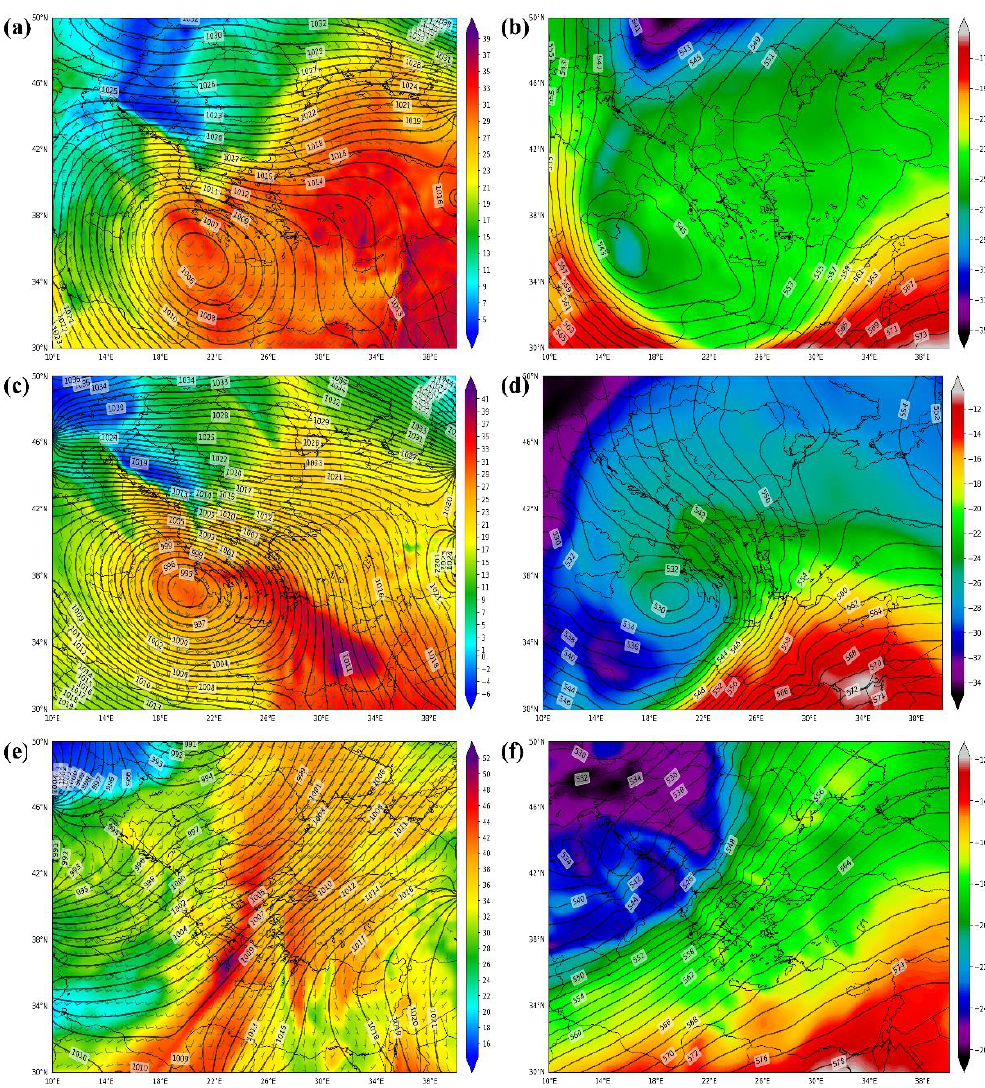
Figure 4. As in Figure 2 but for 24 February 2011, 1200 UTC ( a , b ), 06 February 2012, 1800 UTC ( c , d ), and 29 November 2012, 1800 UTC ( e , f ).